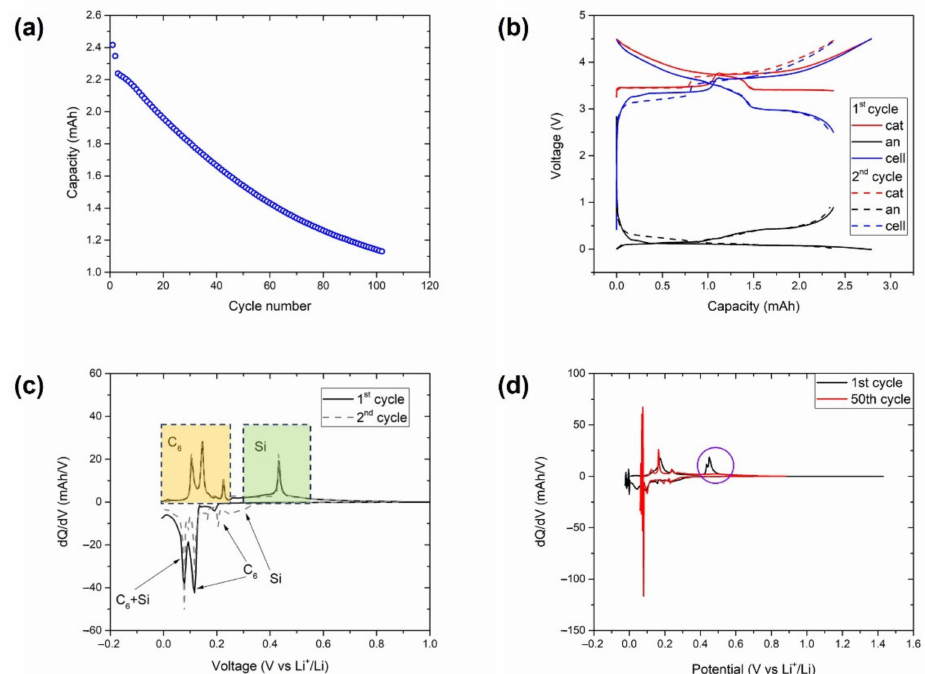
Figure 4. Experiments with a three-electrode cell consisting of an NMC-LFP cathode, a Gr/Si anode, and a Li reference electrode cycled at 25 ◦ C between 2.5 and 4.5 V at a C/3 C-rate. ( a ) Discharge capacity with the cycle count. ( b ) Voltage profiles at C/20. Differential capacity plot at ( c ) C/20 and ( d ) C/3 of the anode voltage profiles. Delithiation features associated with graphite and silicon utilisation in ( c ) are highlighted in yellow and green, respectively. Evidence of a lack of silicon activity after 50 cycles in ( d ) is highlighted in